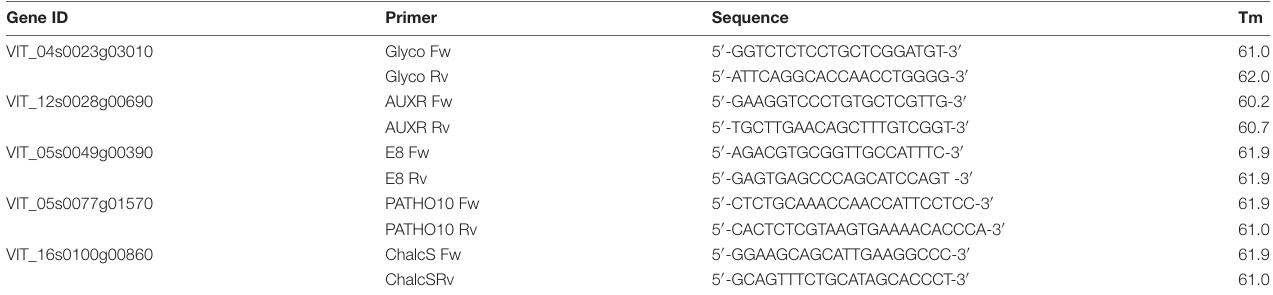
TABLE 1 | List of primers for RT qPCR designed for validating the RNA sequencing analysis. Gene ID